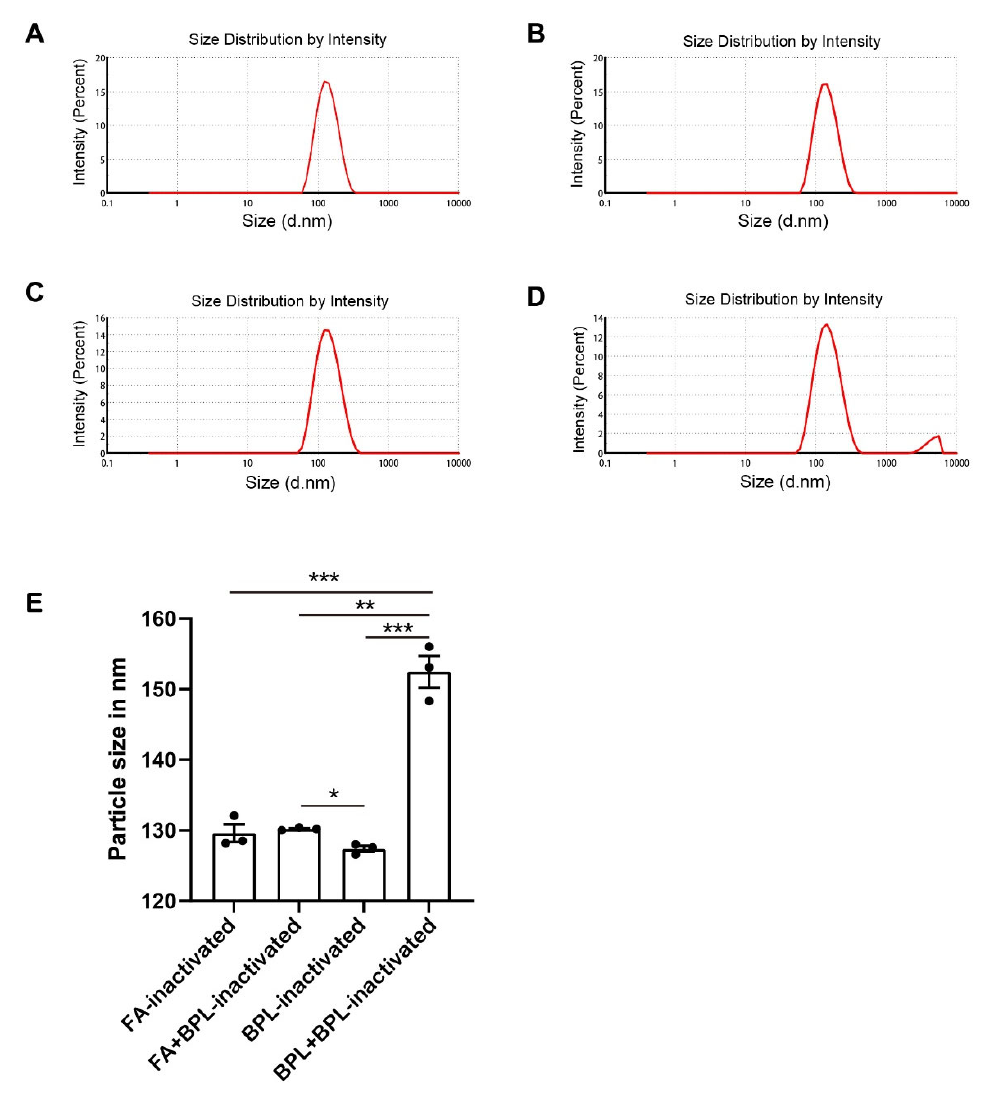
Figure 3. Dynamic light scattering (DLS) analysis graphs of different inactivated virus samples: ( A ) Formaldehyde-inactivated (FA-inactivated).